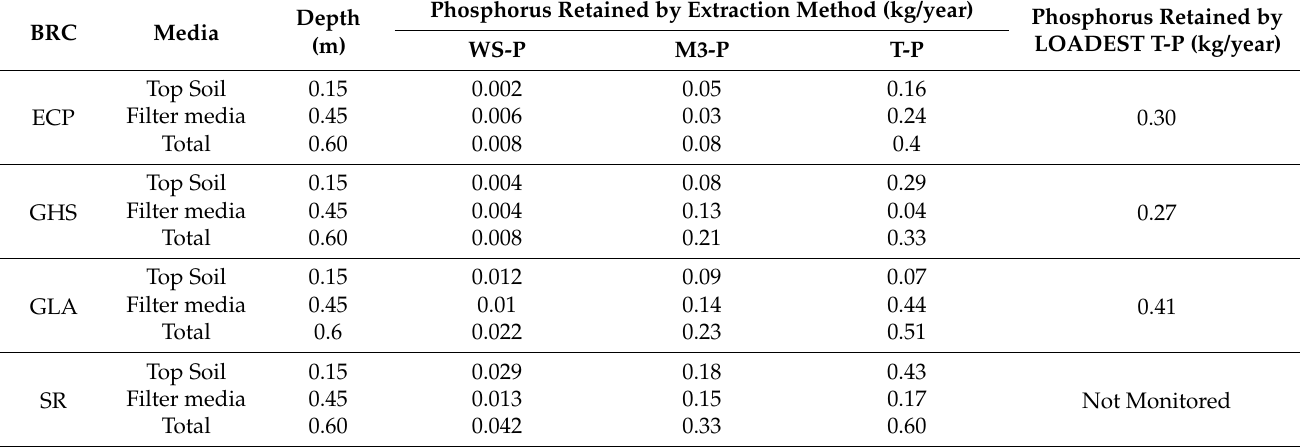
Table 7. Phosphorus mass retention rate within the BRC by core sampling and LOADEST modeling with water sampling results. BRC